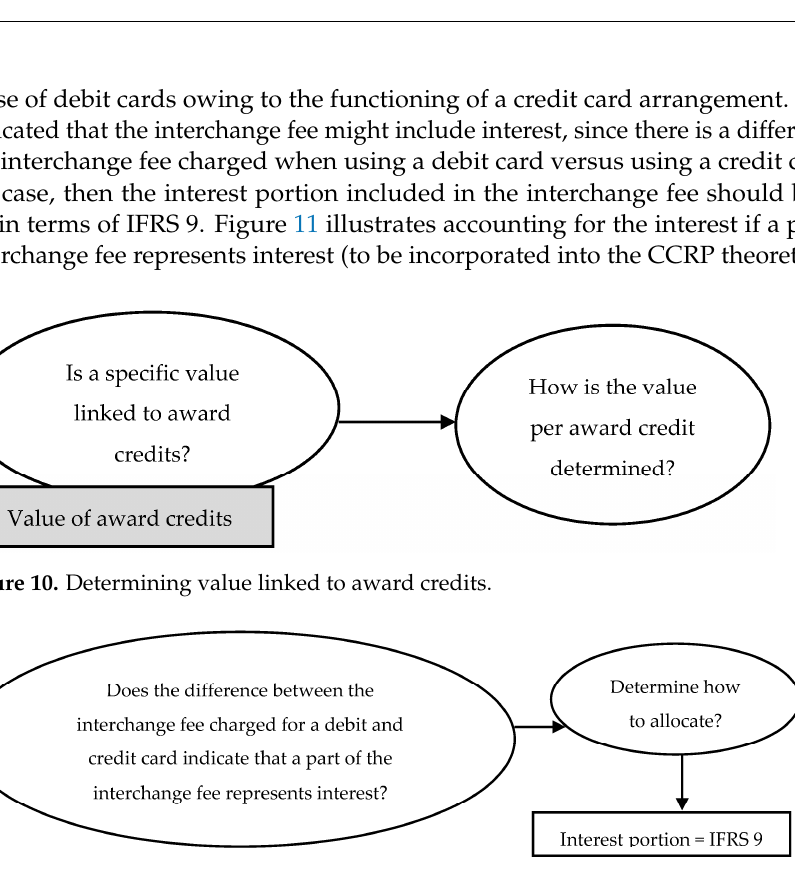
Figure 11. Accounting for interest if portion of interchange fee represents interest.